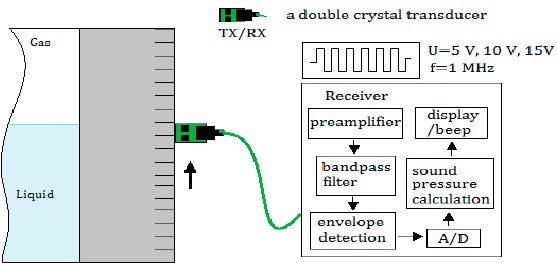
Figure 4. Circuit, metal container, and sensors used in the experiment.